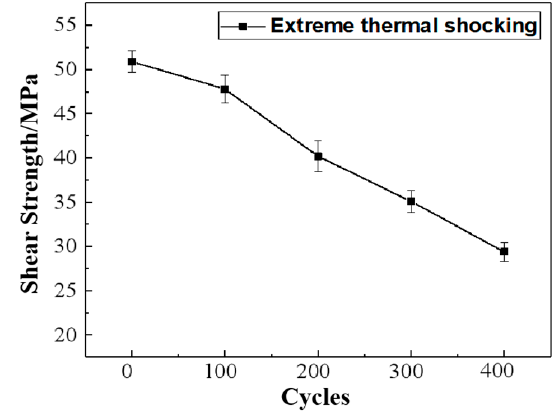
Figure 9. The shear strength of Au-12Ge solder joint during thermal shock.